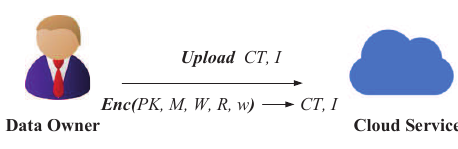
Figure 4. Ciphertext uploaded.